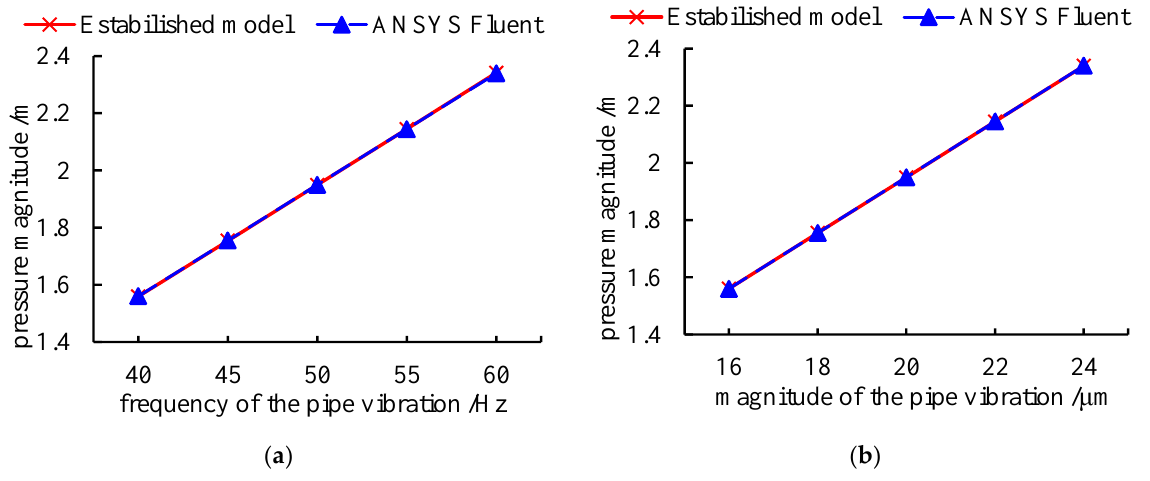
Figure 9. Magnitude of the pressure oscillation. ( a ) Vibration frequency ( b ) vibration magnitude.